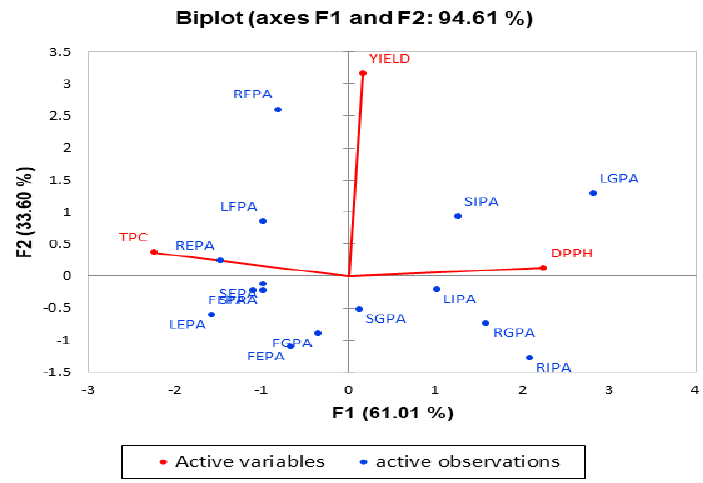
Figure 4. The principal component analysis biplot indicating the correlation circle of the active variables and the scatter plot of the active observations. F1: the first factor or principal component 1 (PC1). F2: the second factor or principal component 2 (PC2).